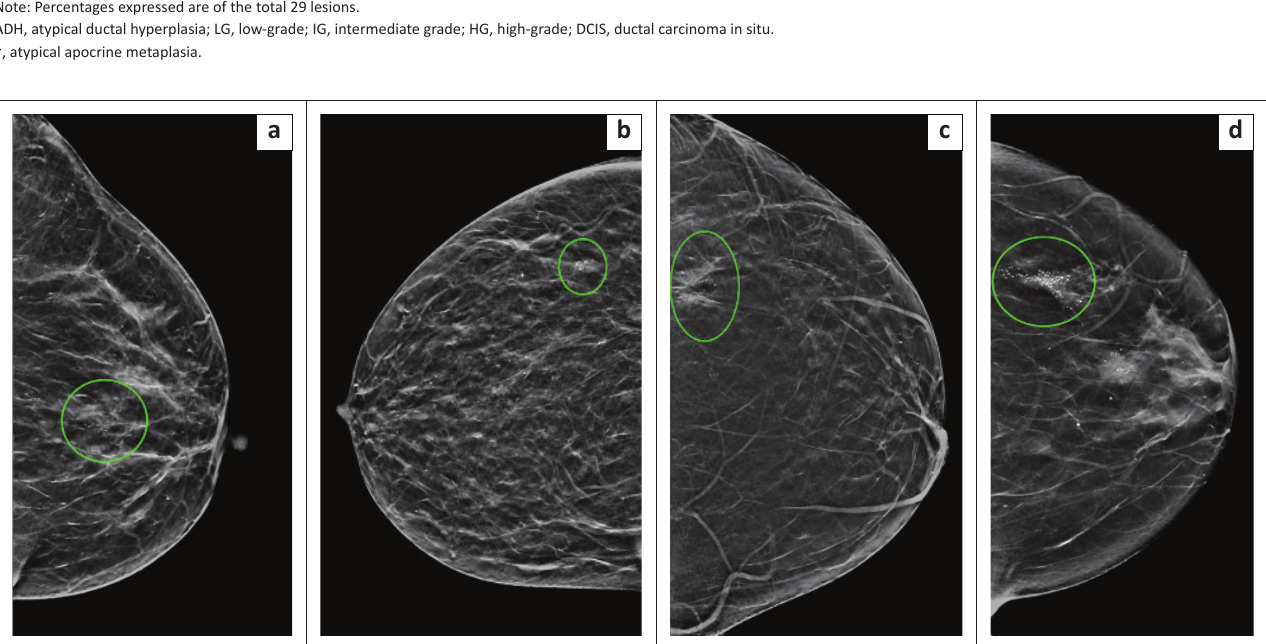
Stereotactic biopsy histology